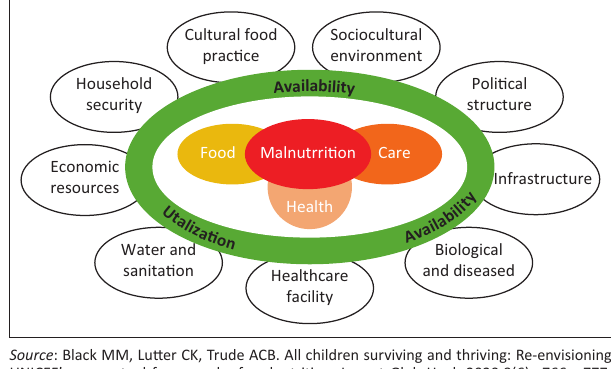
FIGURE 1: Outcomes of childhood malnutrition under the age of 5 years.